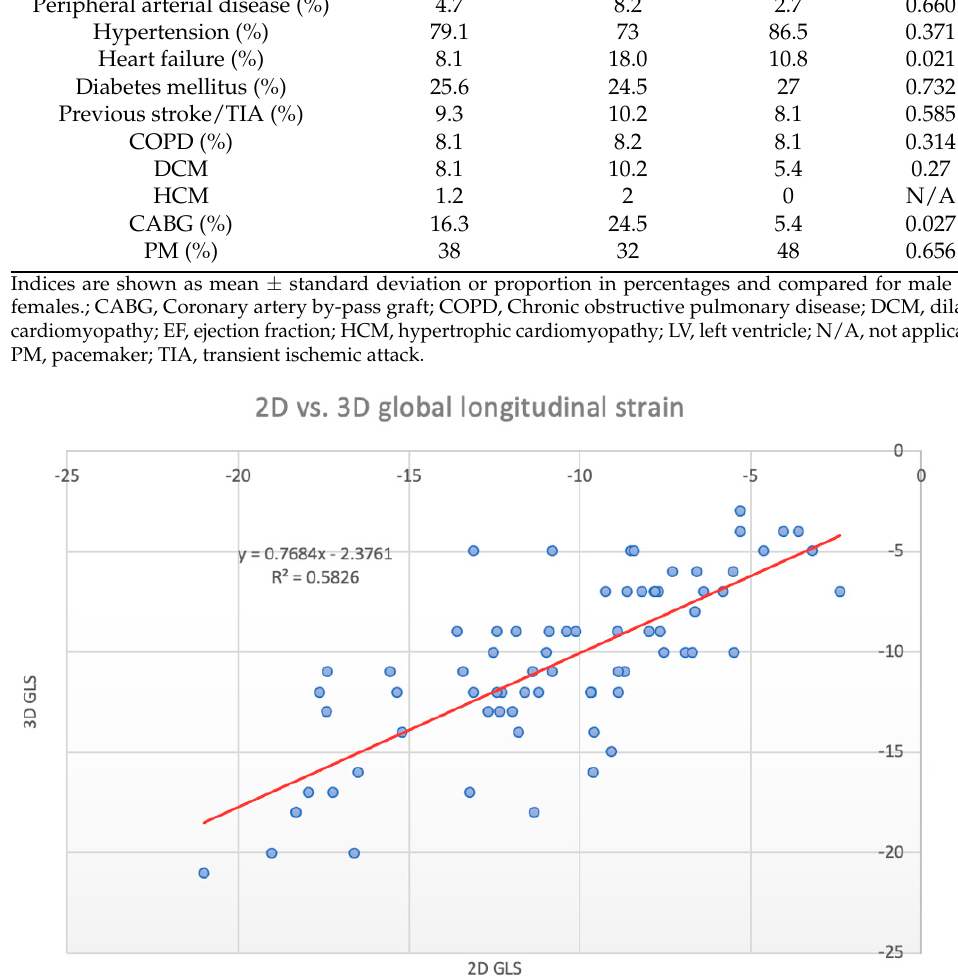
Figure 3. Scatter plot of 2D vs. 3D global longitudinal strain, linear regression equation displayed in the left upper section.